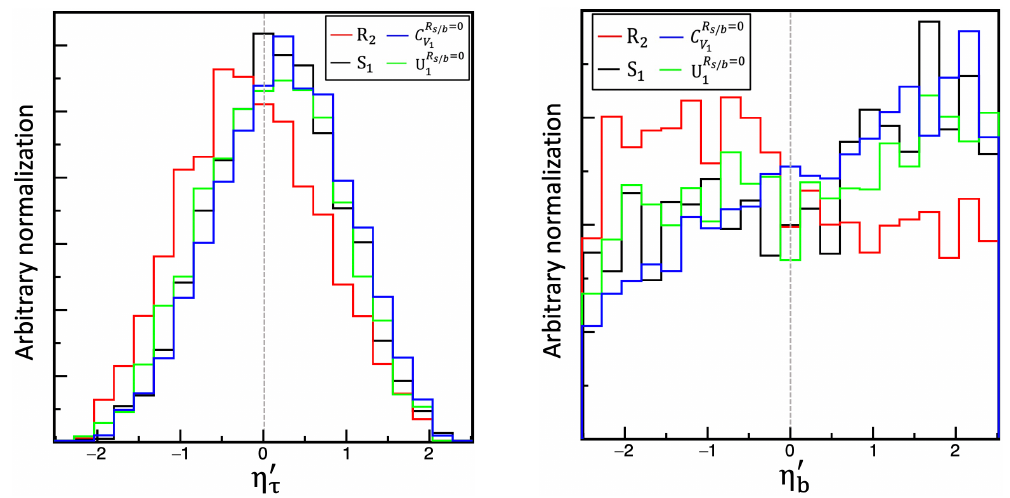
Figure 8 . Distribution of signal event numbers against the modified pseudorapidity η 0 (right) defined by eq. (4.4) in the scenarios of single-R 2 ( C S R s/b =0 (blue), and U(2) -U (light green). Here, M LQ = 1 . 5 TeV is taken, and the normalization of 1 each histogram is